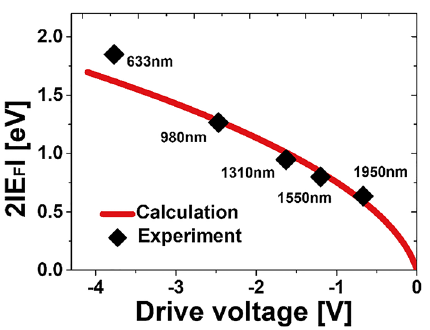
Figure5: Wavelength-dependentelectro-opticcharacteristicsofthe monolayer graphene device as a function of drive voltage. The red line is calculated value and the squared dots are obtained from